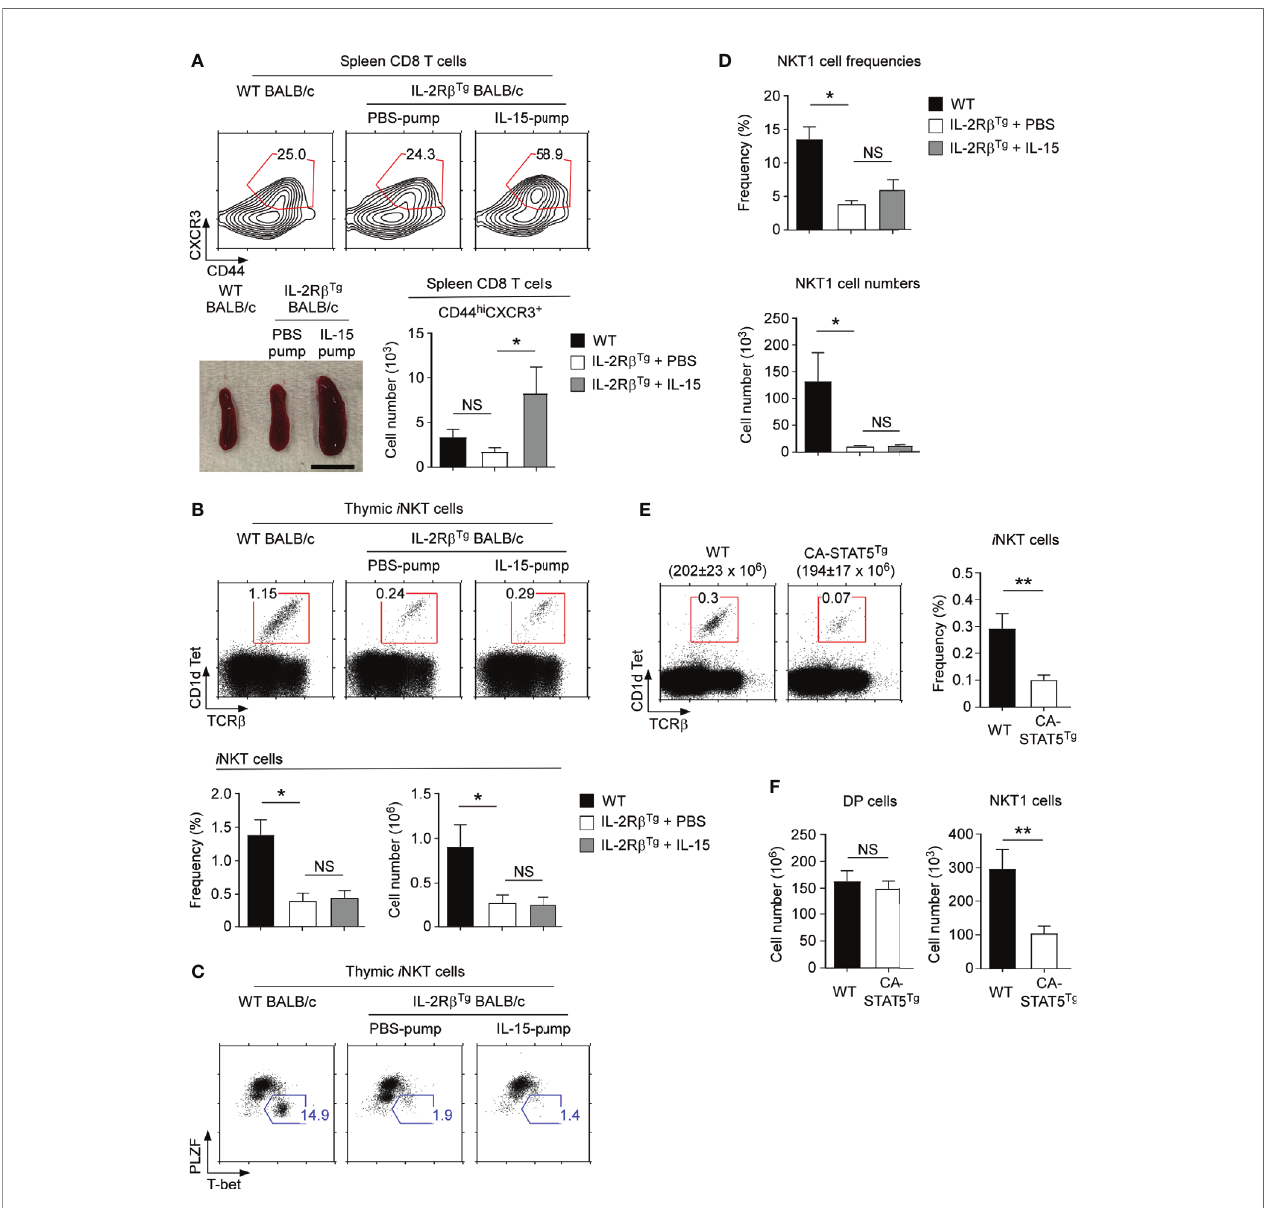
FIGURE 6 | Thymic i NKT cell differentiation in IL-15-infused IL-2R b Tg BALB/c mice (A) Effects of recombinant IL-15- or PBS-releasing Alzet osmotic pump installation on IL-2R b Tg BALB/c mice. Spleen CD8 T cells of IL-2R b Tg BALB/c mice that were infused with IL-15 or PBS for 10 days were assessed for the accumulation of memory-phenotype CD8 T cells by CD44 versus CXCR3 staining. Frequency and numbers of CD44 hi CXCR3 + CD8 T cells are representative of 2 independent experiments with 4 IL-15 pump and 3 PBS pump implanted IL-2R b Tg BALB/c mice (top). Picture shows spleens of IL-2R b Tg BALB/c mice that were implanted with PBS or IL-15 Alzet pumps (bottom). Scale bar = 1 cm. (B) Frequencies and numbers of thymic i NKT cells of IL-2R b Tg BALB/c mice implanted with IL-15- or PBS-releasing Alzet osmotic pumps. Dot plots are representative (top) and graphs are summary (bottom) of 3 independent experiments with a total of 5 IL- 15 pump and 4 PBS pump implanted IL-2R b Tg BALB/c mice. (C) Thymic i NKT subset composition IL-2R b Tg BALB/c implanted with IL-15 or PBS-releasing Alzet osmotic pumps. NKT1 cells were identi fi ed by PLZF versus T-bet of HSA lo mature thymic i NKT cells. Results are representative of 3 independent experiments with 5 IL-15 pump and 4 PBS pump implanted IL-2R b Tg BALB/c mice. (D) Frequencies and numbers of NKT1 cells in IL-2R b Tg BALB/c implanted with IL-15 or PBS- releasing Alzet osmotic pumps. Results are summary of 3 independent experiments with 5 IL-15 pump and 4 PBS pump implanted IL-2R b Tg BALB/c mice. (E) Frequency of thymic i NKT cells in CA-STAT5 Tg and littermate C57BL/6 mice. The dot plots show thymic i NKT cells as identi fi ed by CD1dTet versus TCR b staining (left). The total thymocyte numbers are shown above the dot plots as the means ± SEM (left). The bar graph shows the frequency of i NKT cells from the indicated mice (right). The dot plot is representative, and the bar graphs are a summary of 4 independent experiments with a total of 7 CA-STAT5 Tg and 8 littermate WT mice (F) Cell numbers of DP thymocytes and thymic NKT1 cells from CA-STAT5 Tg and littermate WT C57BL/6 mice. Bar graph shows the summary from a total of 7 CA-STAT5 Tg and 5 littermate WT mice. *P < 0.05; **P < 0.01. NS, Not Signi fi